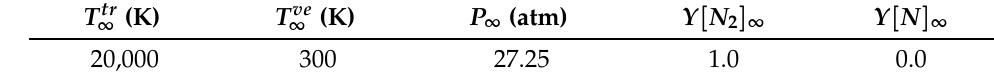
Table 1. N 2 thermal bath initial conditions.